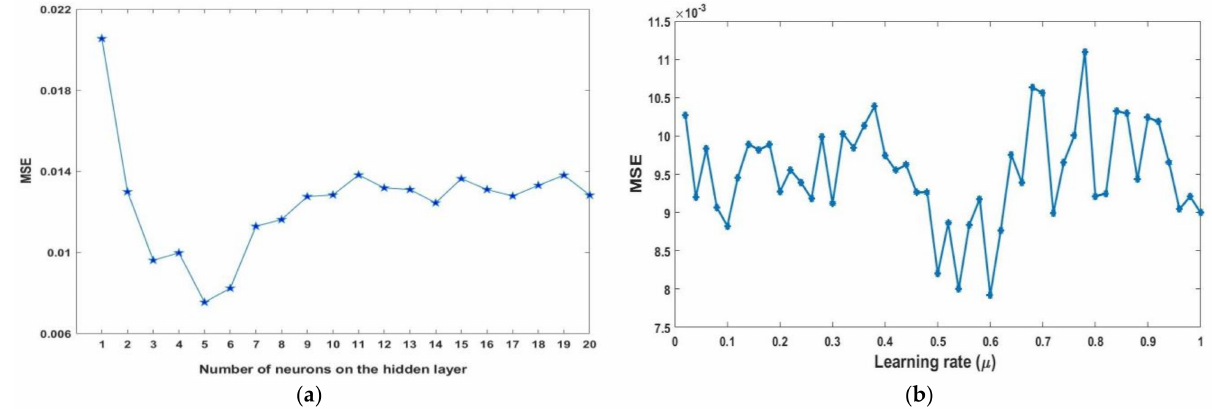
Figure 5. ANN performance (MSE) when: ( a ) the number of neurons in the hidden layer is varied; ( b ) the learning rate ( µ ) is